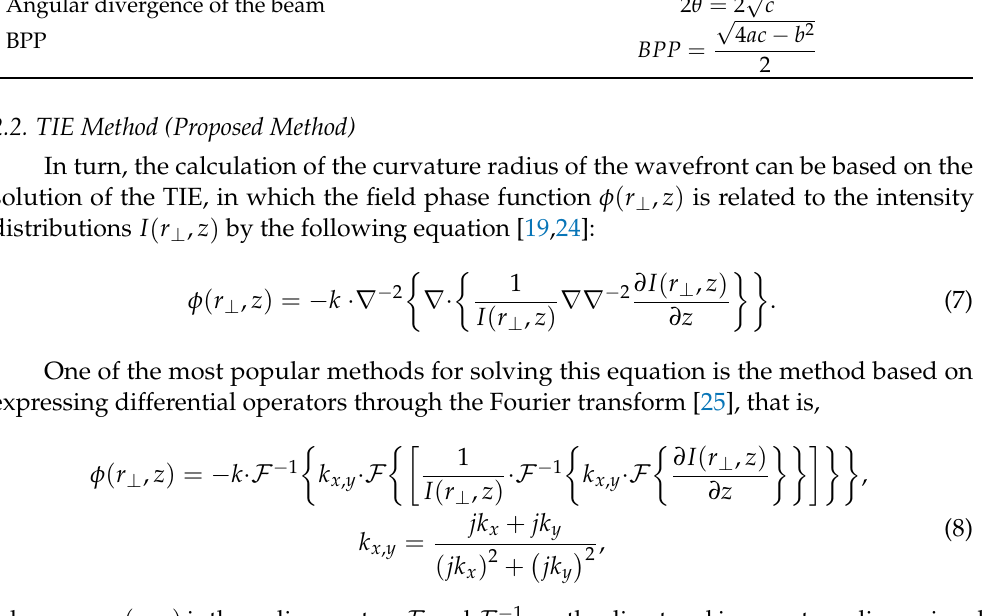
Table 1. Functional dependences of spatial parameters of the laser beam on a , b , c . Parameters Equations Radius of the laser beam waist w Position of the beam waist relative to the selected reference plane (taking into account the sign rule adopted in optics) Rayleigh length z Angular divergence of the beam 2 θ = 2 BPP BPP =